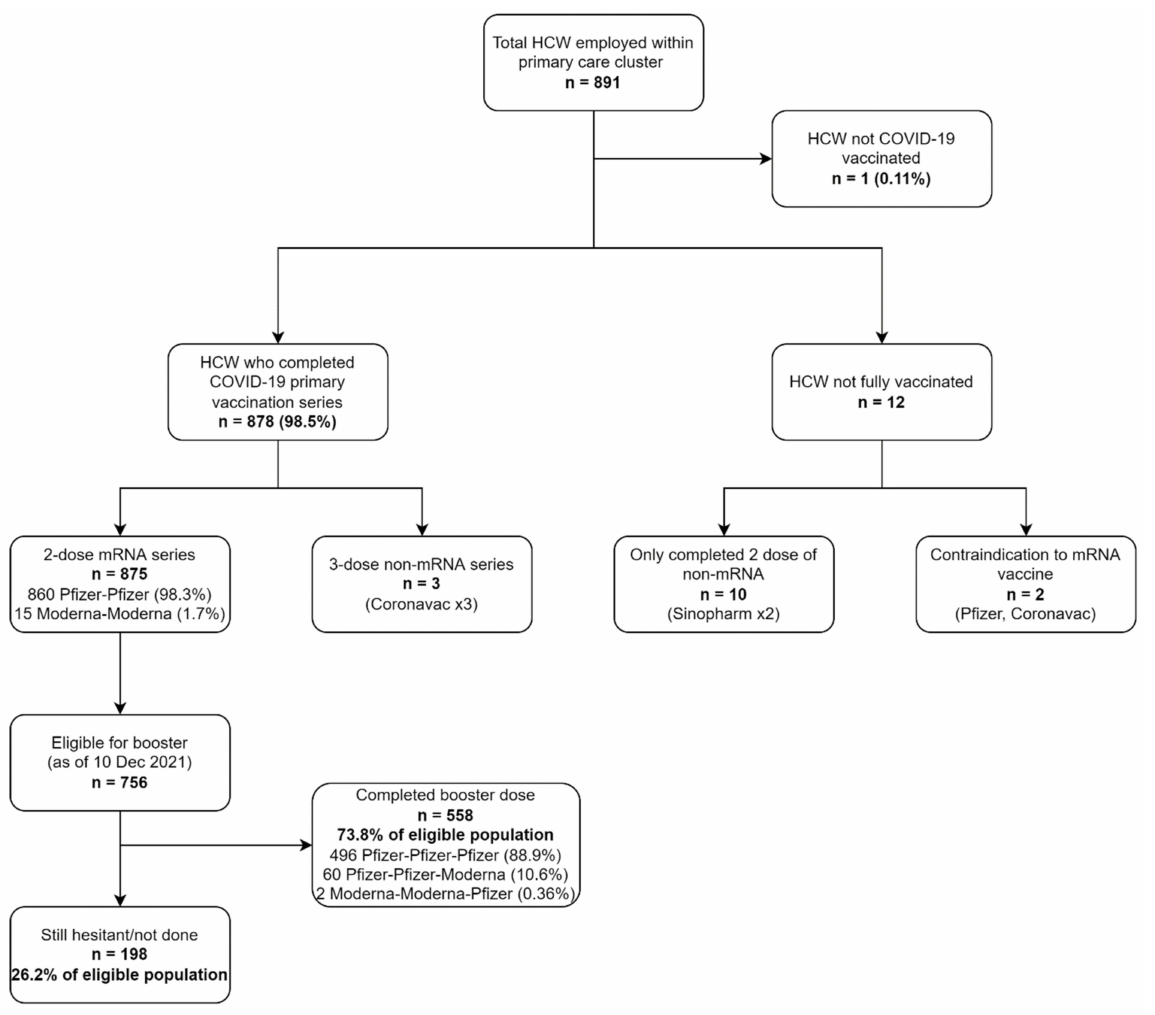
Figure 1. The state of COVID-19 vaccination among